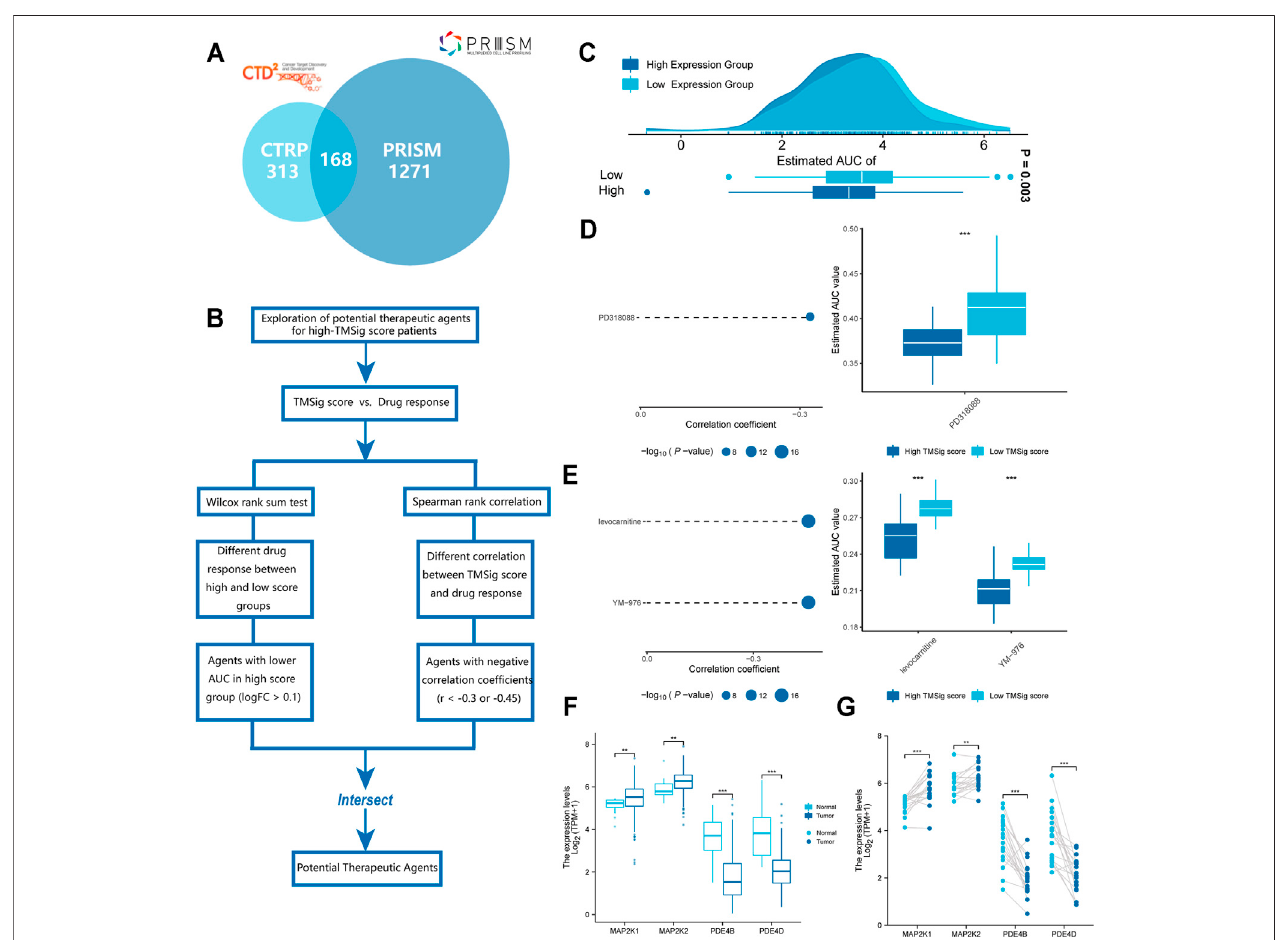
FIGURE 6 | Identi fi cation of candidate agents with higher drug sensitivity in high-TMSig score patients. (A) A venn diagram of compounds from the CTRP and the PRISM datasets. (B) Schematic outlining the strategy for identi fi cation of potential therapeutic agents. (C) Comparison of estimated cisplatin ’ s sensitivity (logAUC) between high GULP1 expression and low GULP1 expression groups. (D) The results of differential drug response analysis and Spearman ’ s correlation analysis of compounds from CTRP datasets. (E) The results of differential drug response analysis and Spearman ’ s correlation analysis of compounds from PRISM datasets. (F) Unpaired comparative analysis of target genes for potential drugs. (G) Paired comparative analysis of target genes for potential drugs.